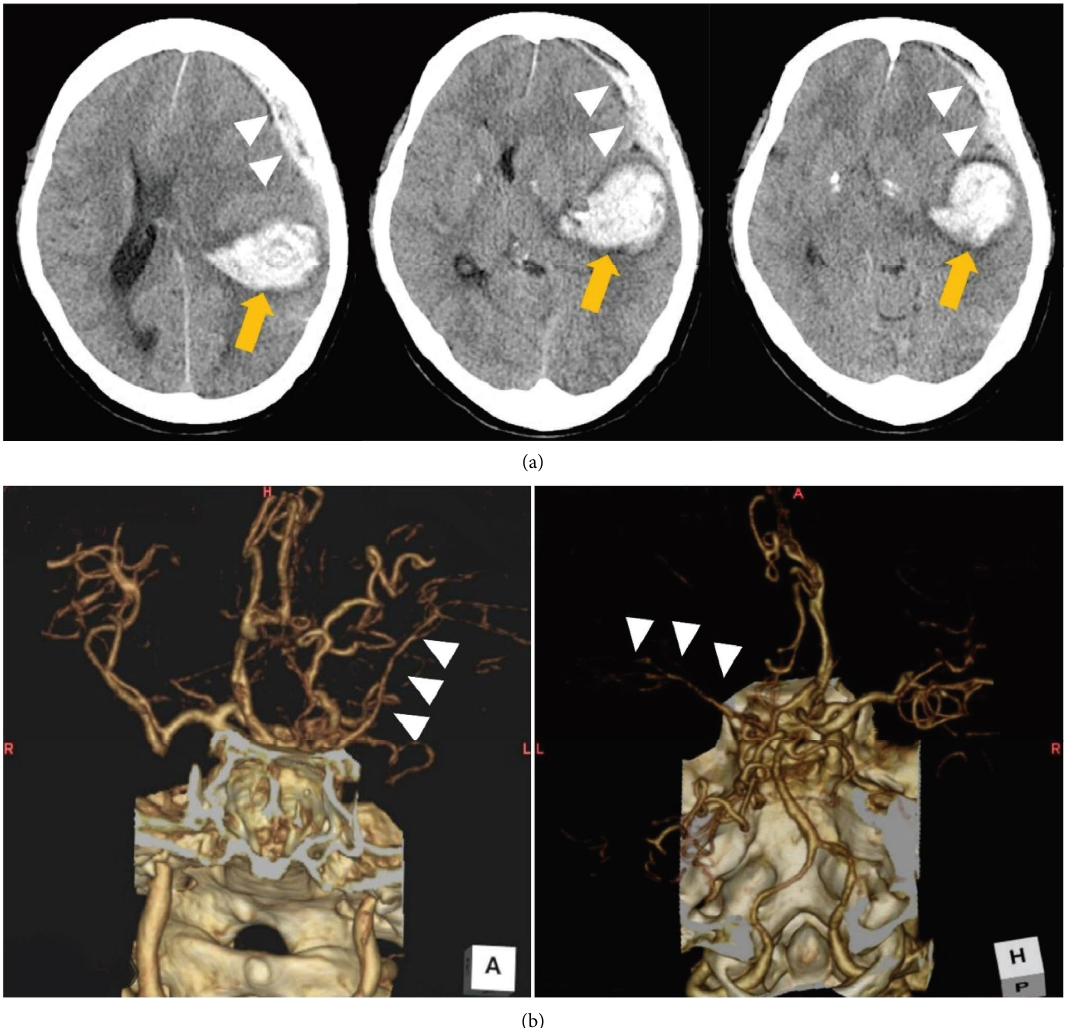
Figure 1: Preoperative radiological examinations. (a) Computed tomography (CT) showed subcortical temporoparietal hemorrhage (arrow) and subdural hematoma (arrowheads) with midline shift of the cerebrum as well as uncal herniation. (b) Tree-dimensional CT angiography indicated scarcely enhanced the left middle cerebral artery (arrow heads): (left) anterior-posterior and (right) posterior- anterior